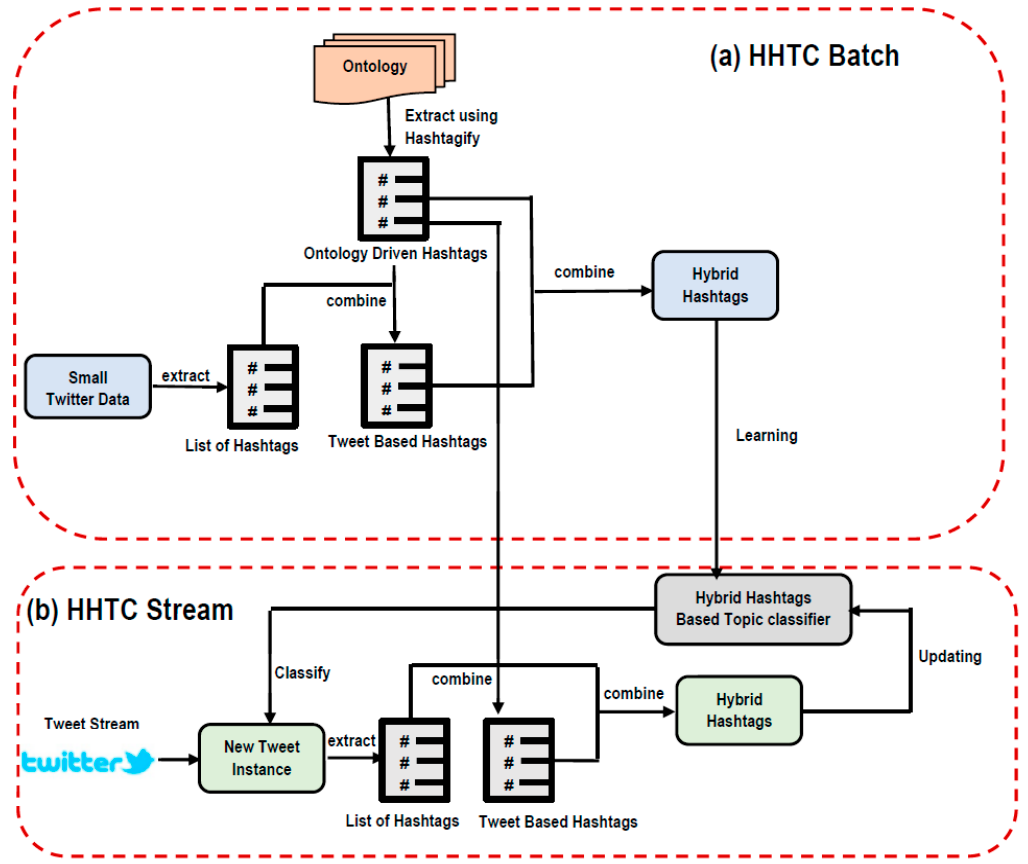
Figure 3. Hybrid Hashtag-based Tweet topic classification (HHTC) framework: ( a ) upper part shows the HHTC-Batch version; ( b ) lower part shows the HHTC-Stream version.